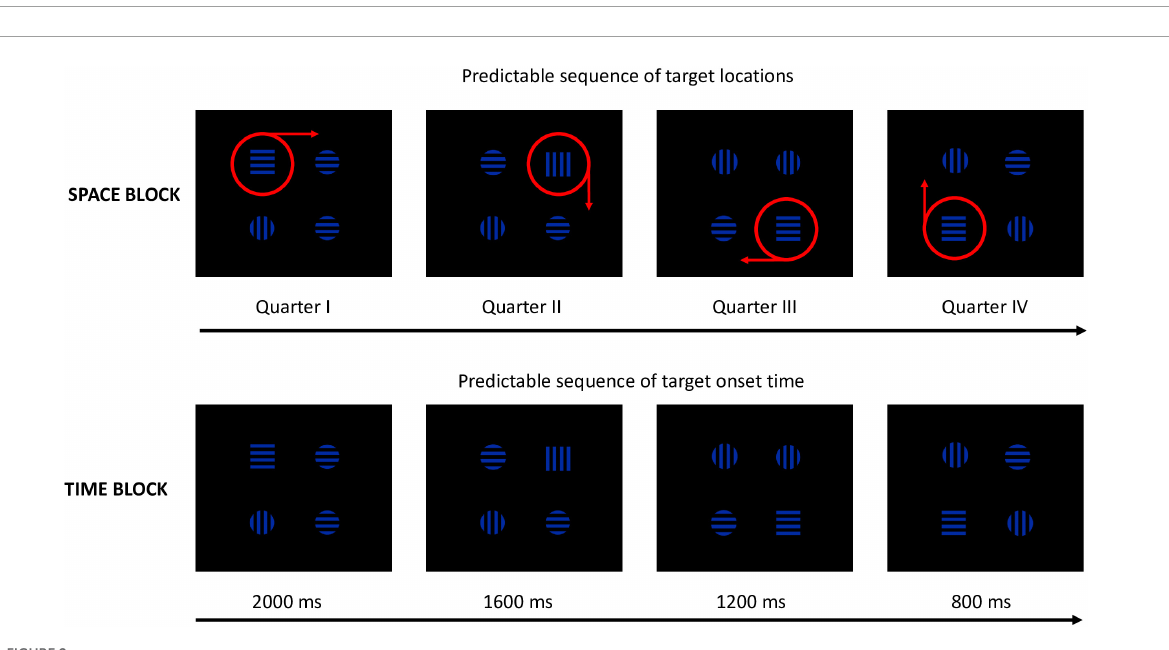
FIGURE2 Examples of the spatial and temporal sequences (The red circles and arrows were not displayed on the